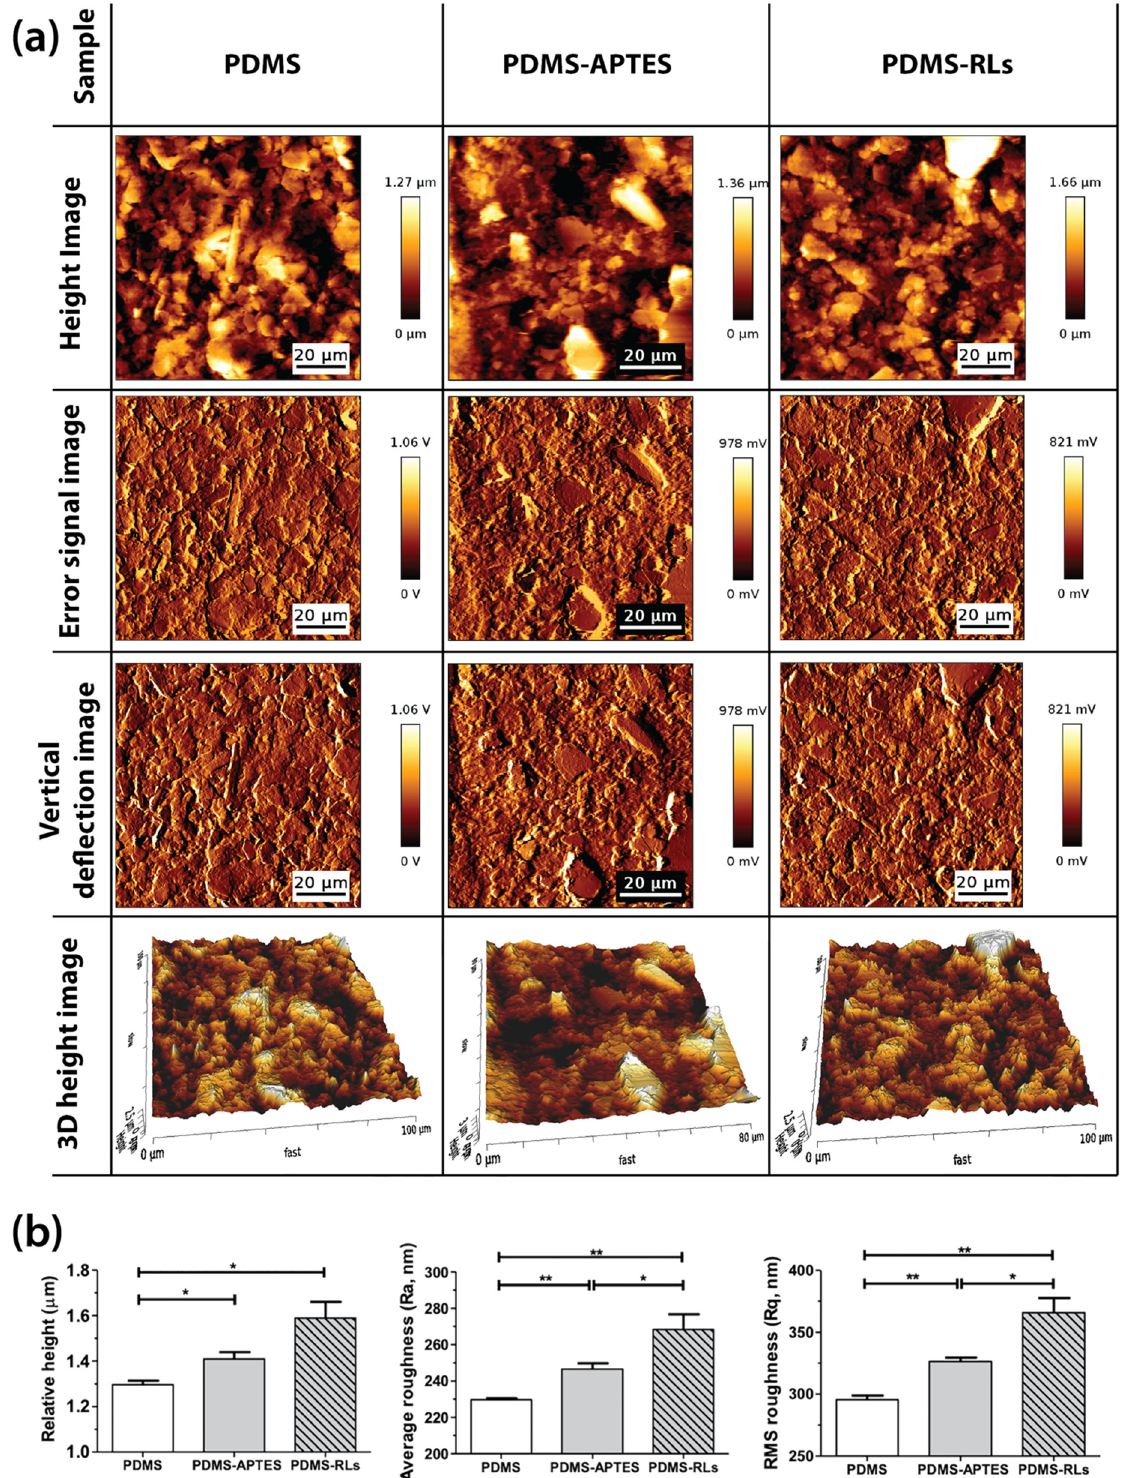
Figure 3. ( a ) Atomic force microscopy images of PDMS, PDMS–APTES and PDMS–RLs. Height AFM images at a non-fixed scale (1st column). Error signal and vertical deflection signal images (2nd and 3rd column, respectively). 4th column: AFM height “3D image” at a fixed scaled of 1 µm and error signal image (100 µm × 100 µm); ( b ) relative height, average roughness (Ra) and root mean square (RMS) roughness (Rq) data obtained from the AFM images of PDMS, PDMS–APTES and PDMS–RLs surfaces (relative height: * p < 0.029; Ra: * p = 0.045; ** p < 0.0073; Rq: * p = 0.027; ** p < 0.0057).